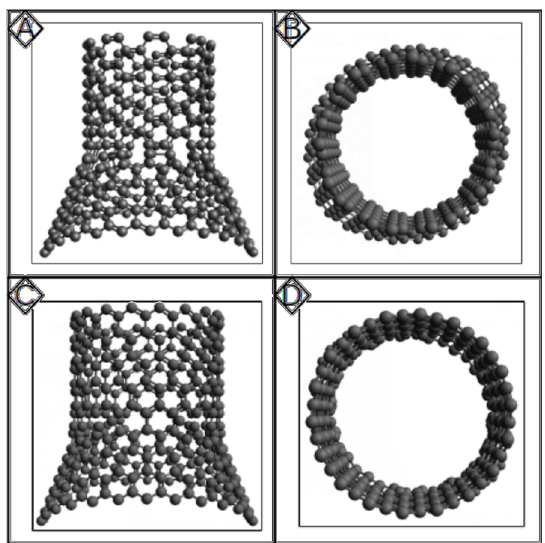
Figure 9. ( A ) Sideview of a carbon nanotube (9,9) of input length 1 nm with a carbon nanocone of disclination level 4 and base radius of 20 Å. ( B ) Top view of a carbon nanotube (9,9) of input length 1 nm with a carbon nanocone of disclination level 4 and base radius of 20 Å. ( C ) Sideview of a carbon nanotube (18,0) of input length 1 nm with a carbon nanocone of disclination level 4 and base radius of 20 Å. ( D ) Top view of a carbon nanotube (18,0) of input length 1 nm with a carbon nanocone of disclination level 4 and base radius of 20 Å.